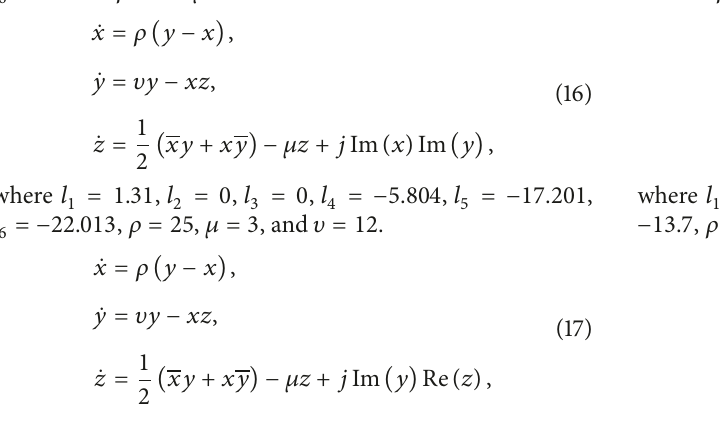
where 𝑙 1 = 0.549 , 𝑙 2 = 0 , 𝑙 3 = 0 , 𝑙 4 = −4.19 , 𝑙 5 = −11.540 , = −17.72 , 𝜌 = 20 , 𝜇 = 2.5 , and 𝜐 = 18 𝑙 6